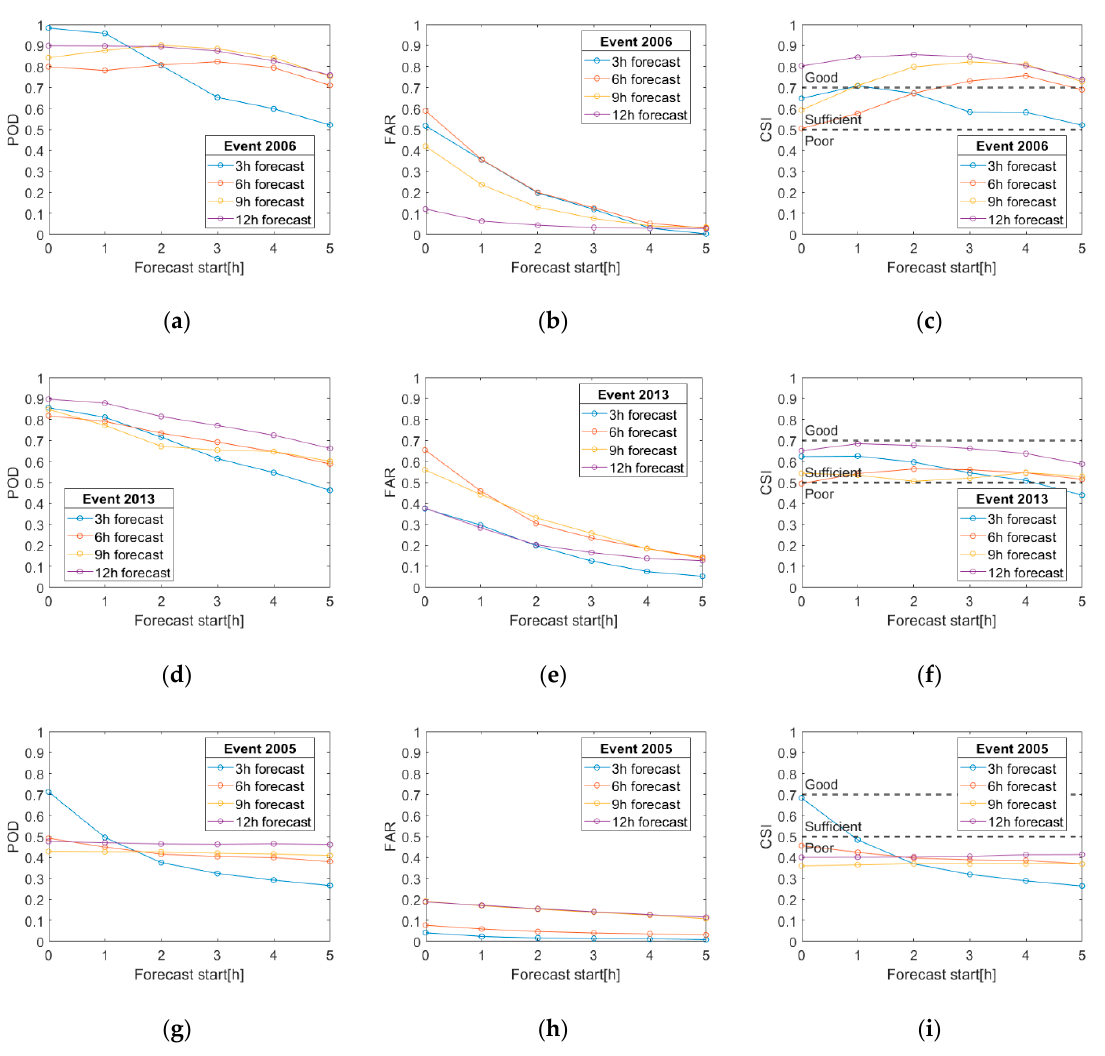
Figure 11. Performance of the forecast of inundation extent growths by three indices. ( a ) probability of detection (POD) in flood event 2006; ( b ) false alarm ratio (FAR) in flood event 2006; ( c ) critical success index (CSI) in the flood event 2006; ( d ) POD in flood event 2013; ( e ) FAR in the flood event 2013; ( f ) CSI in flood event 2013; ( g ) POD in flood event 2005; ( h ) FAR in flood event 2005; ( i ) CSI in flood event 2005.